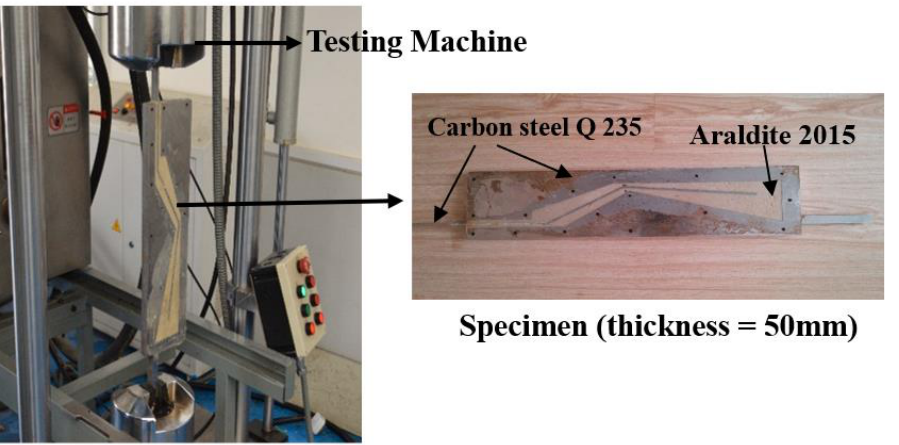
Figure 9. Experiment setup of model test.